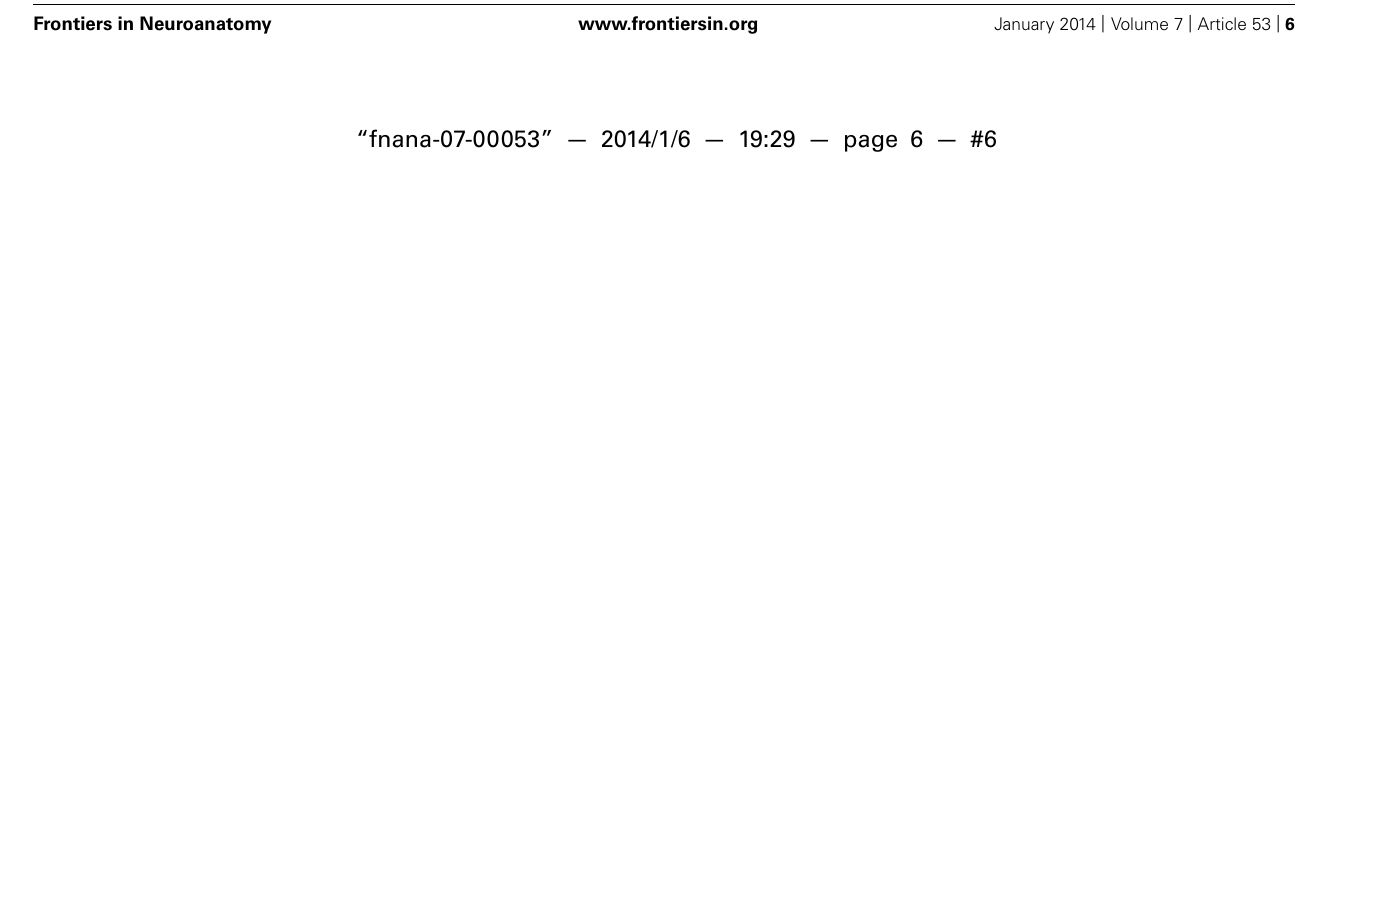
(Seeger et al., 1994; Costa et al., 2007; Hilbig et al., 2007) leads us to conclude that WFA is staining many PNs in the guinea pig